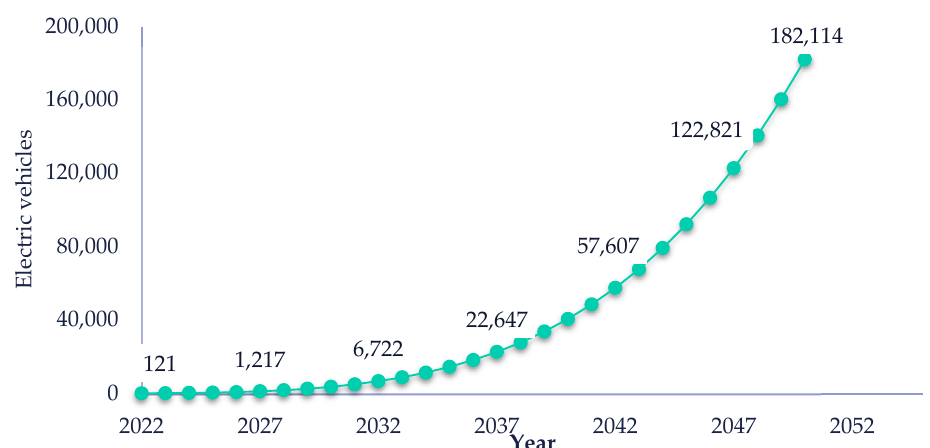
Figure 11. EV growth forecast until 2050 in the city of Cuenca.